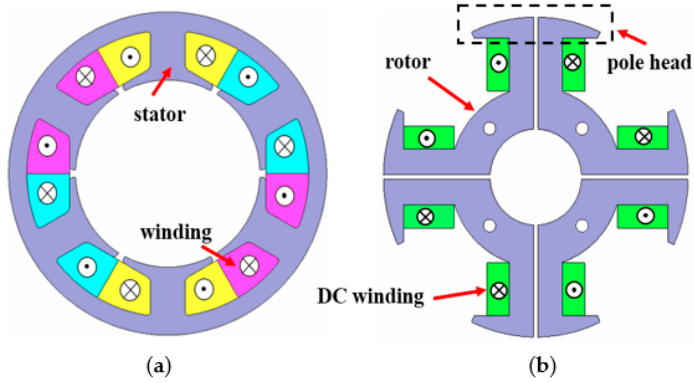
Figure 1. Topology of the basic model. ( a ) Stator ( b ) Basic rotor. Table 1. Specifications of the basic model.